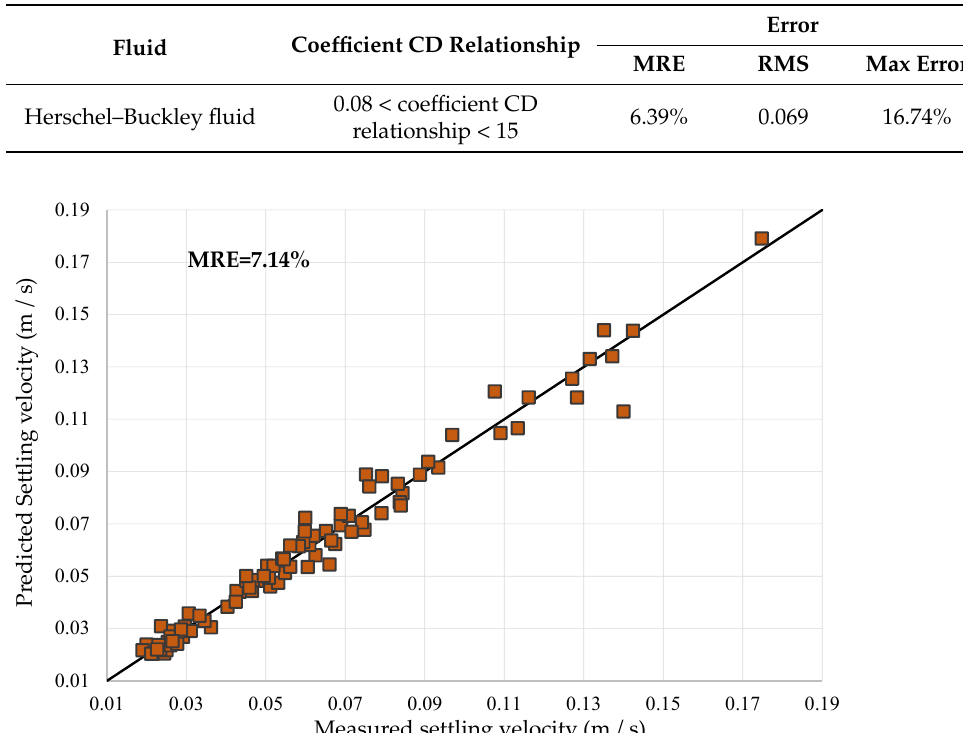
Figure 12. Comparison of prediction results of drag coefficient C D and C D, sph exp f ( c ) measured by shale cutting settling experiment. Table 5. Error statistics of shale cuttings drag coefficient.